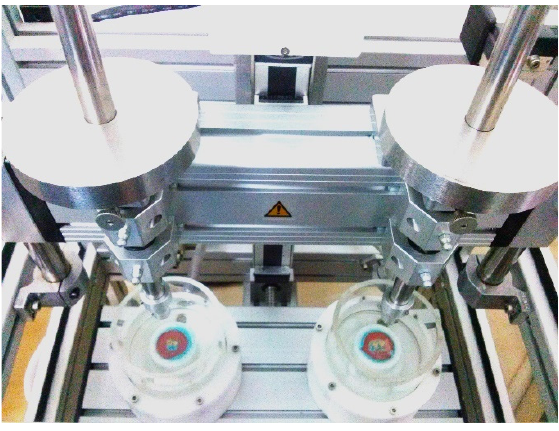
Figure 3. The testing of the samples using a dual-axis chewing simulator.